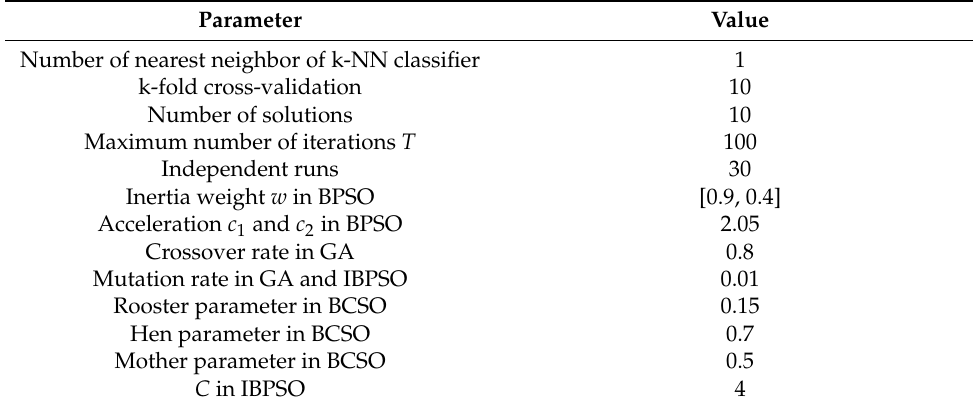
Table 2. Parameter setting for this